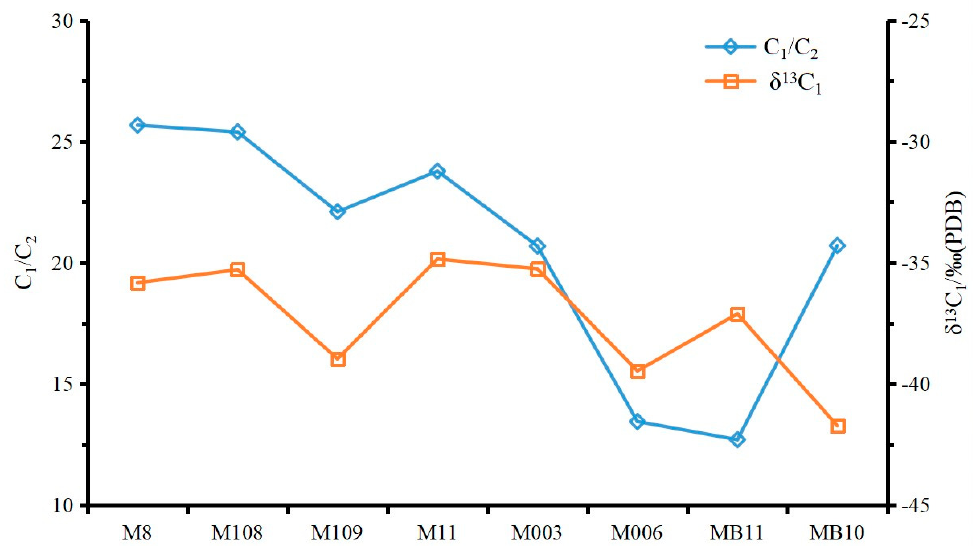
Figure 8. Geochemical parameters of the Mobei bulge in the eastern belt around the Penyijingxi sag, Junggar Basin.